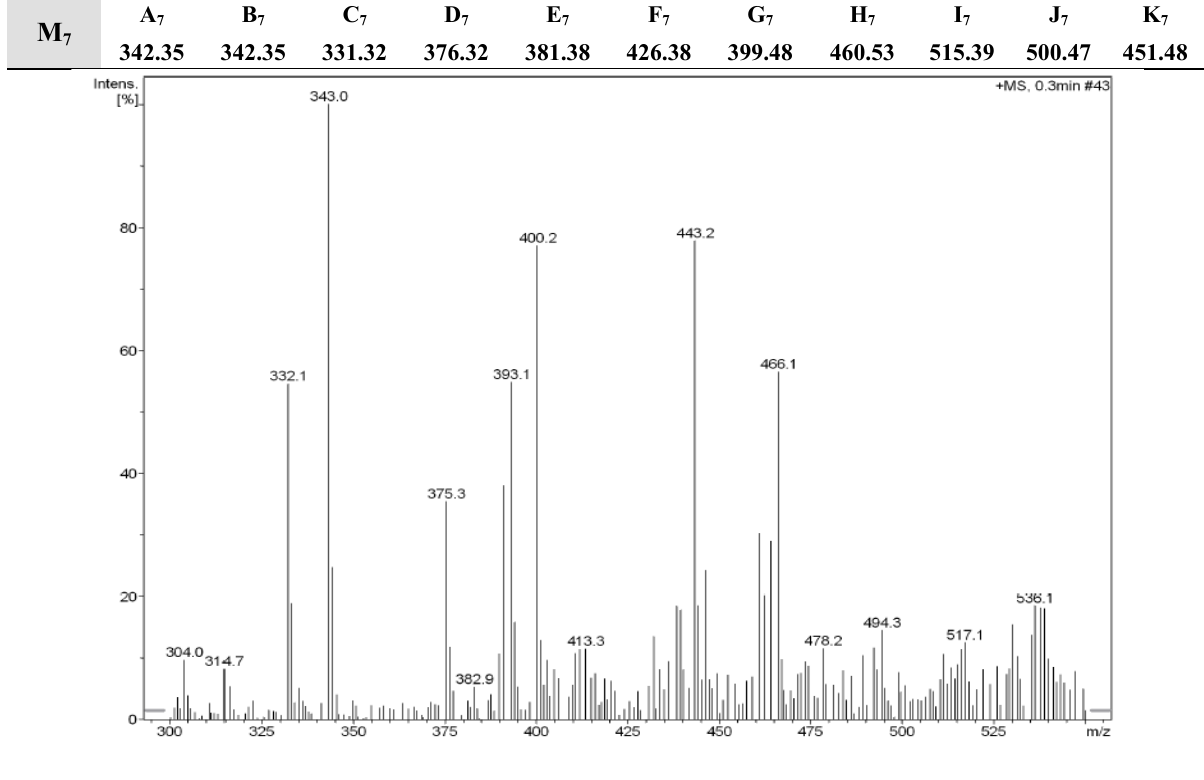
Figure 1. DART-MS of M